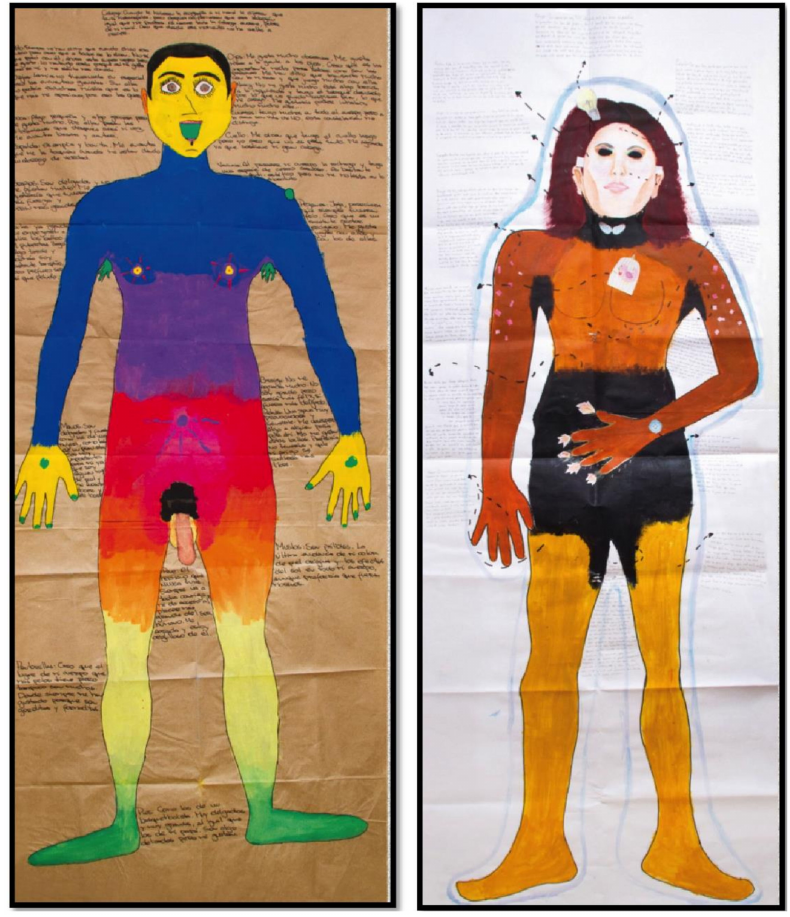
Figure 1. Examples of intertextual maps of the